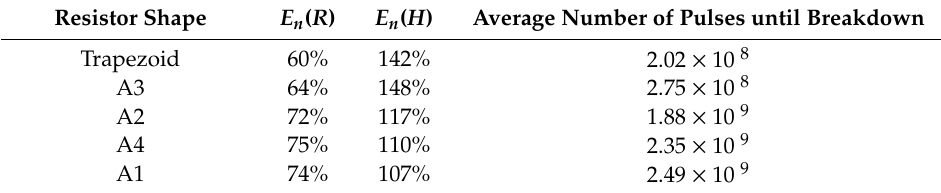
Table 2. Experiment results sorted by lifetime achieved in comparison to the simulated normalized electric